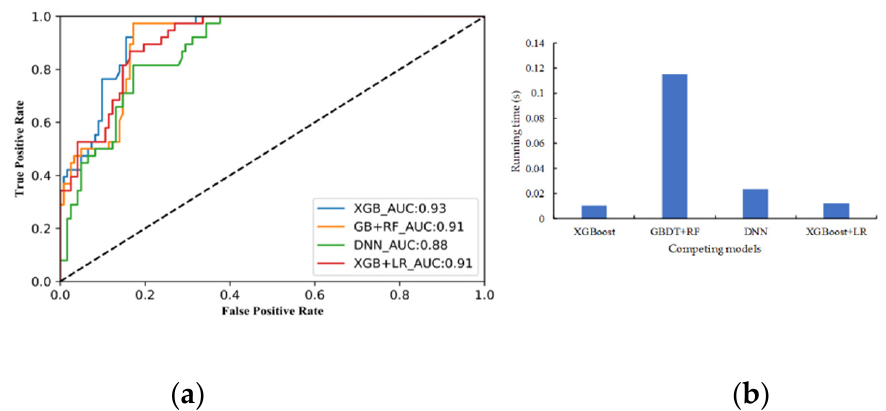
Figure 18. ( a ) Receiver operating characteristic curve (ROC) and the area under the curve (AUC) of intermingledness evaluation model; ( b ) the running time of competing models.